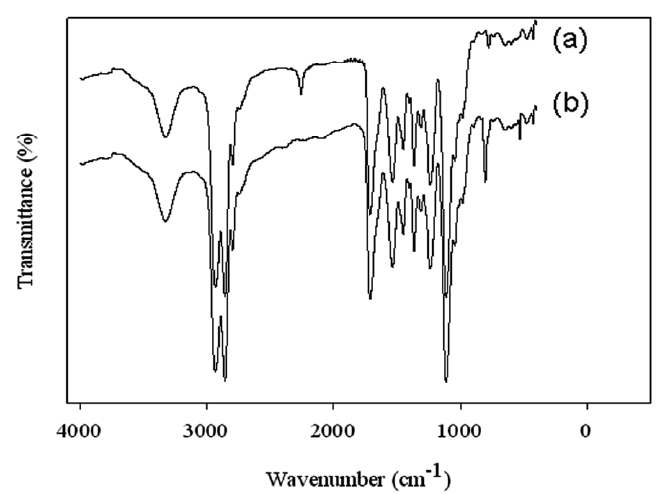
Figure 1. FT-IR spectra of reaction stages during preparation of WBPU-PDMS-Ce dispersion, ( a ) before adding f -OFA-CeO 2 into prepolymer and ( b ) after completion of reaction between f -OFA-CeO 2 and prepolymer followed by dispersion and chain extension.